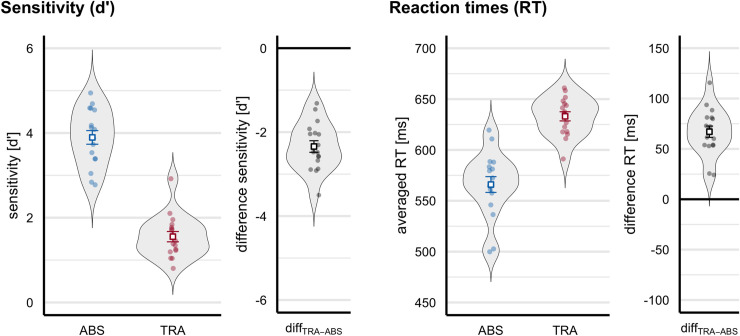
Violin plots depict behavioural performance measures as a function of condition.The plots show (n = 17 participants) sensitivity (d’) in discriminating true pattern changes from pattern repetitions (left panel), and averaged reaction times (RT) when correctly responding to true pattern changes (right panel). The absolute condition is depicted in blue, the transposed in red and the respective absolute–transposed difference in black. Small dots represent each participant’s mean performance, the bold square the group average and error bars ± 1 SEM. Participants detected true pattern changes well above chance even in the absence of absolute pitch. Nonetheless, sensitivity to true pattern changes based on relative compared to absolute pitch information is lower (d’: M = -2.34) and the behavioural response on average 67 ms slower respectively.